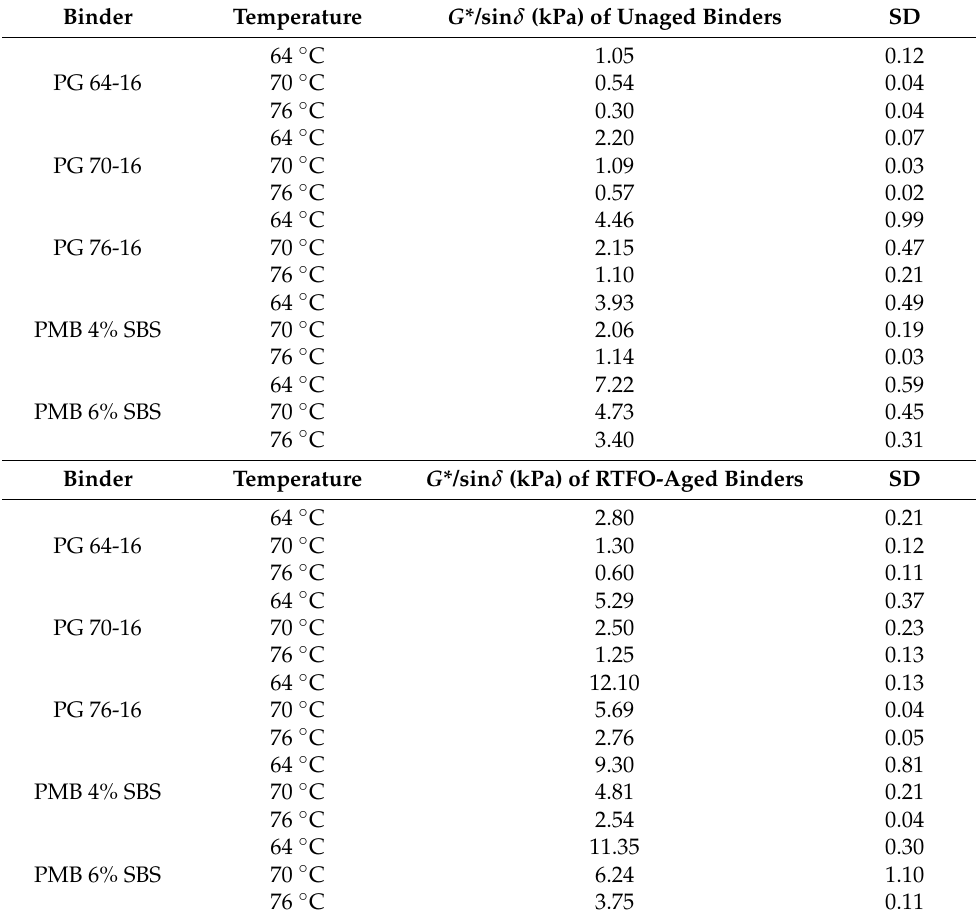
Table 3. DSR high-temperature test results of unaged and RTFO-aged binders.